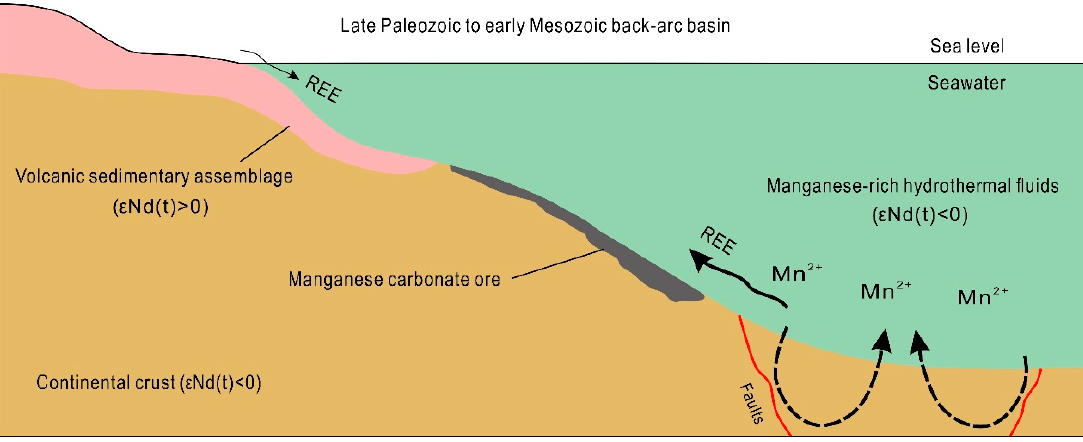
Figure 10. Schematic diagrams showing a sedimentary model for the Ortokarnash manganese ore deposit in a back-arc basin.